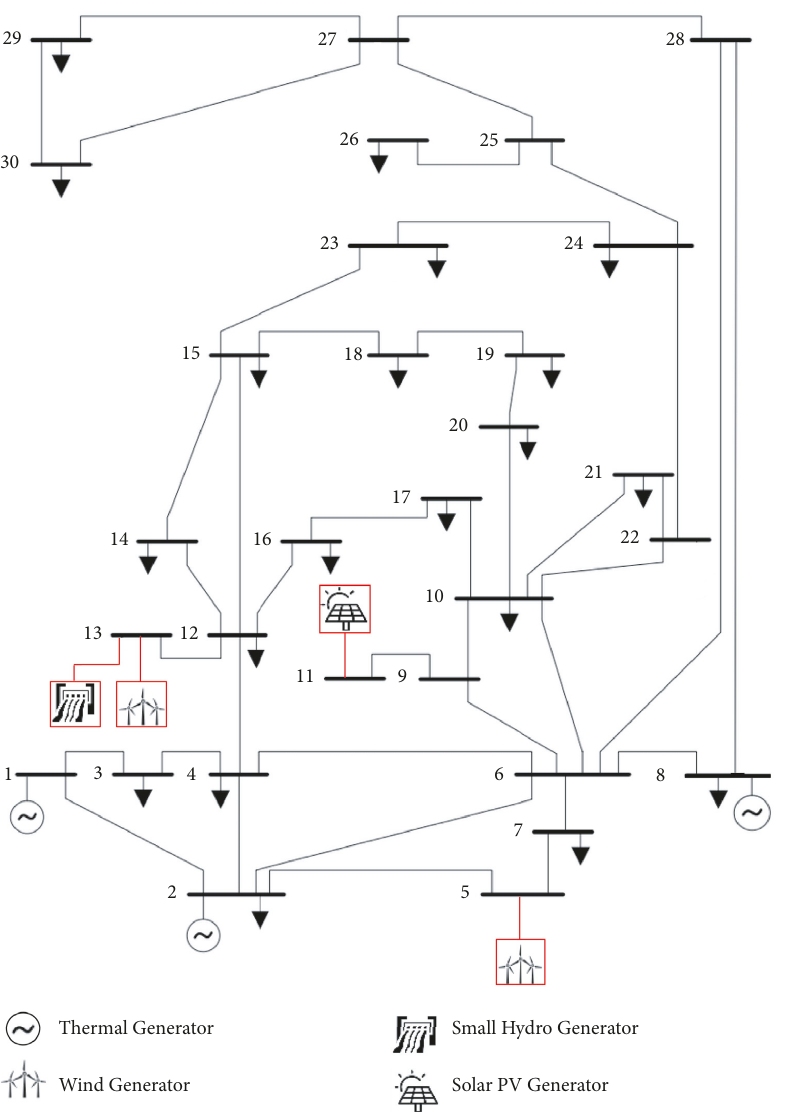
Figure 4: Modified IEEE 30-bus consisting of wind, solar, hydro, and thermal generators. Table 4: Details of the modified IEEE